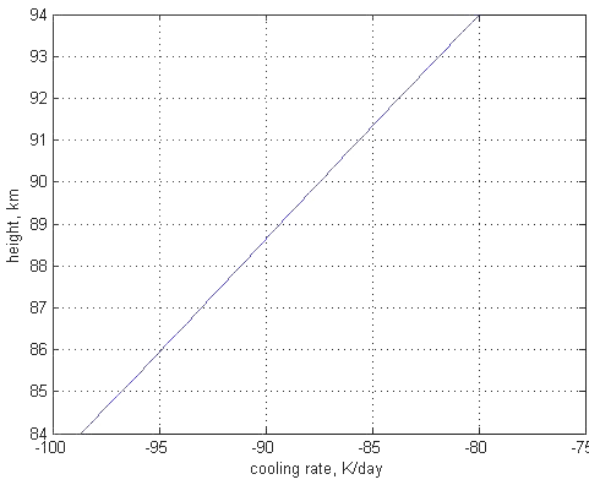
Fig. 6b. Height profiles of the cooling rate calculated with K eh = K ed inferred from the [He] distribution in summer solstice ( K m 5 × 10 6 cm 2 s − 1 , s = 0 . 01km − 2 , c = 0 . 8, P = 1).